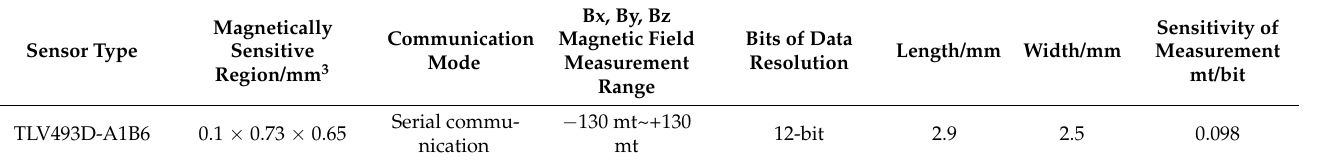
Table 2. Parameters of the 3D magnetic